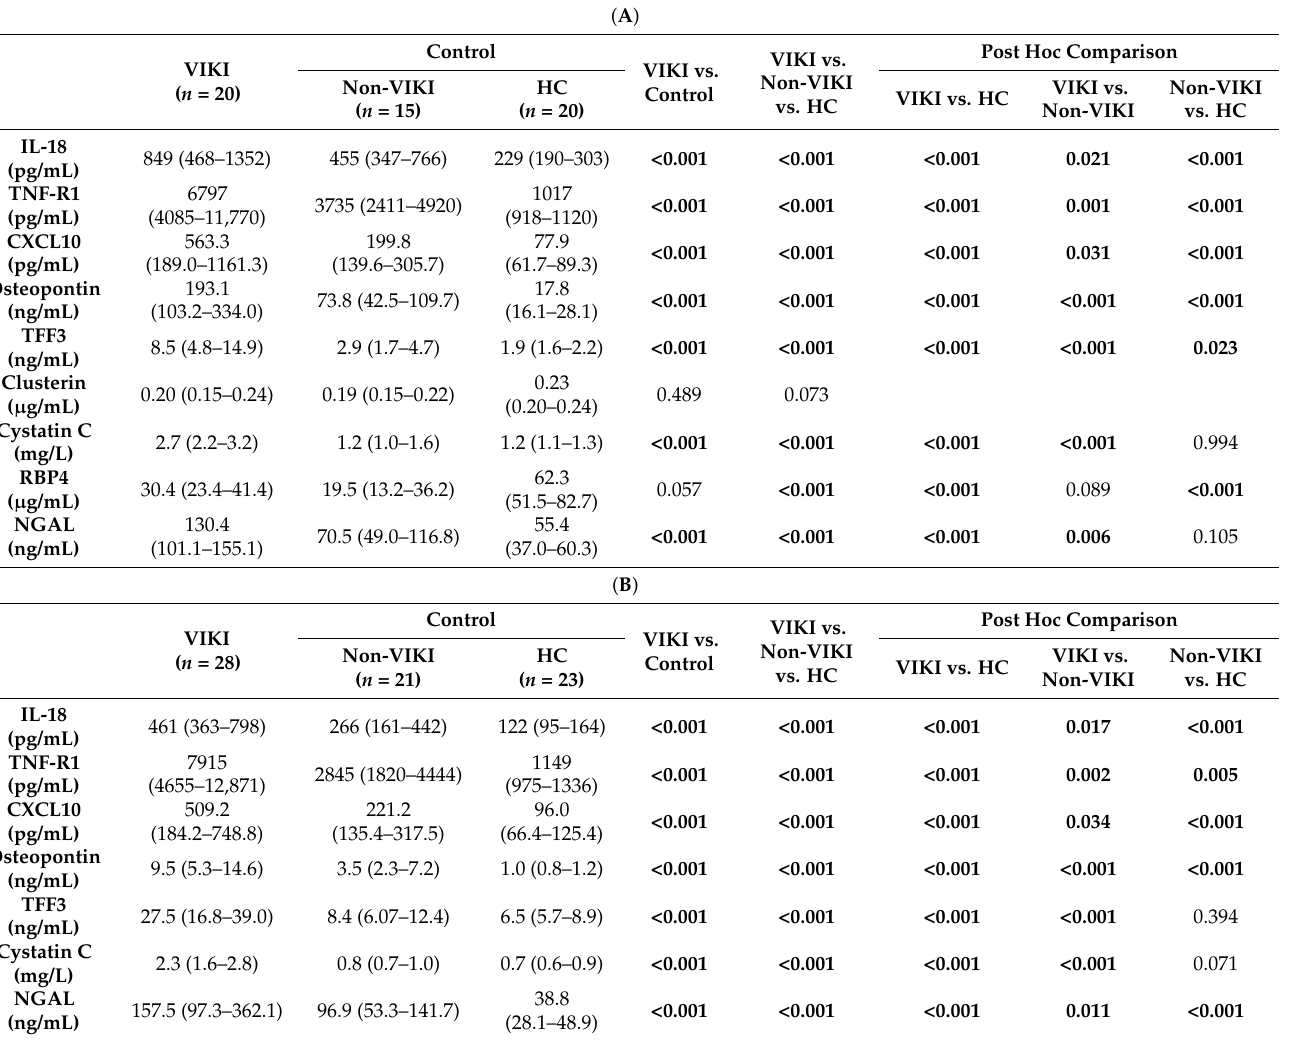
Table 2. Serum biomarker concentrations in the ( A ) screening test by Luminex assay ( n = 55) and the ( B ) validation test by ELISA ( n =